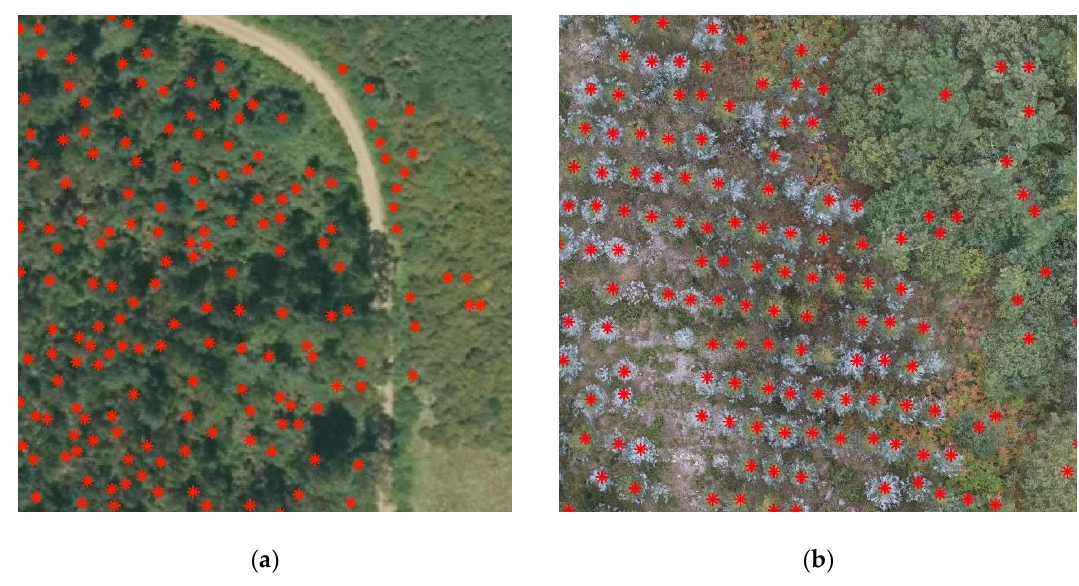
Table 5. Optimum configuration selected for each dataset for the watershed delineation algorithm. 329